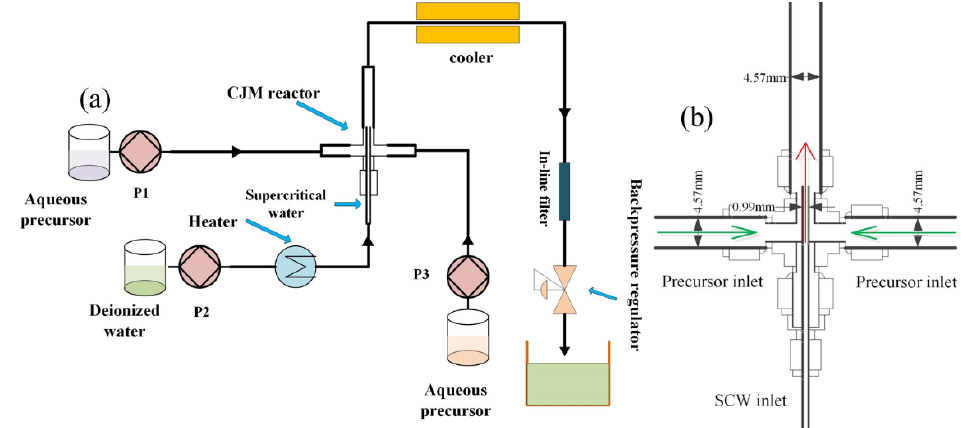
Figure 1. ( a ) Flow diagram of the CHFS system and ( b ) a schematic diagram of the CJM reactor.